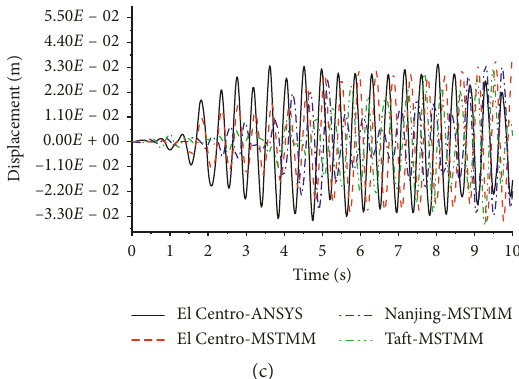
2 ). (a) 10mm, (b) 40mm, and